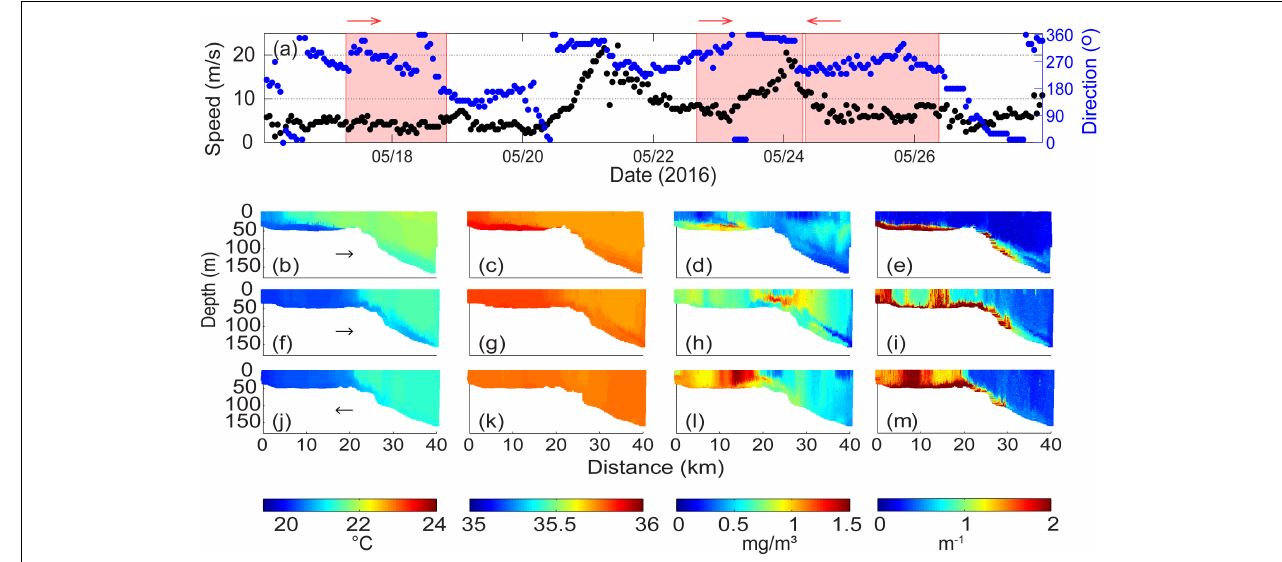
FIGURE 10 | (a) Wind velocity and direction at Rottnest Island during 17–26 May 2016. The shaded areas represent the period of ocean glider transect; Ocean glider vertical cross-sections of (b) temperature ( ◦ C); (c) salinity; (d) chlorophyll (mgm − 3 ); and (e) backscatter (m − 1 ) across the Rottnest continental shelf during 17–18 May 2016; (f–i) water properties during 22–24 May 2016; and (j–m) water properties during 24–26 May 2016. The glider flight direction is indicated by the